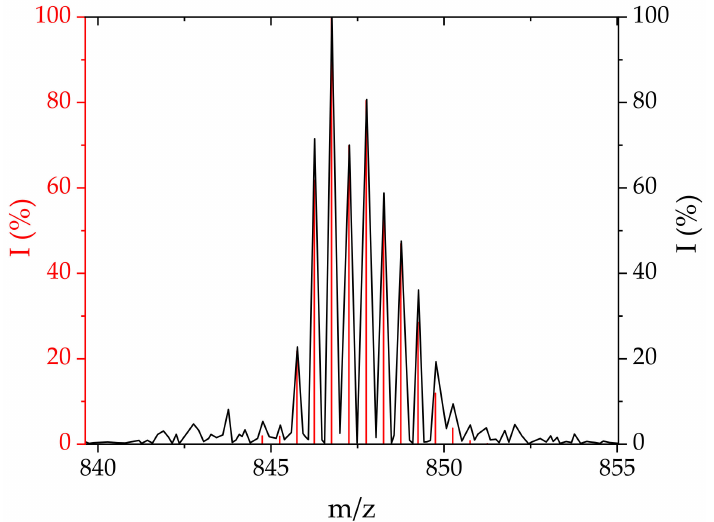
Figure 6. Mass spectra of 4 as recorded by ESI-MS in postreaction mixture (180 ◦ C, 0.4 Bar, 4.0 L/min) (black) and simulated using The Isotope Distribution Calculator (red).